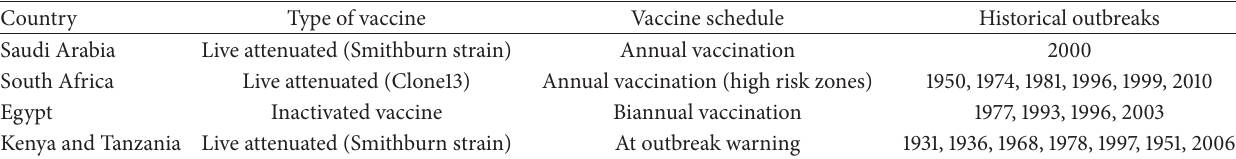
Table 1: Vaccination program in Africa and Arabian Peninsula